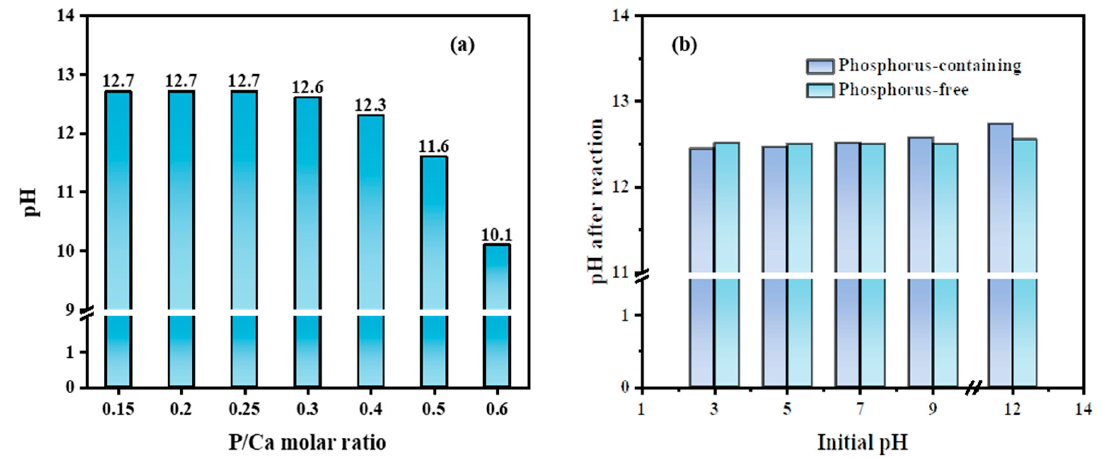
Figure 5. The pH of ( a ) P/Ca and ( b ) P i006E solution after reaction. To study the influence of the pH of the solution on the removal of B, acidic CaCl 2 instead of COS was used as a Ca 2+ source to precipitate P and remove B from solution. Re- moval efficiency increased as pH increased from 10 to 12.5, and peaked at pH 12.5, followed by a rapid decrease as pH increased (Figure 6). Dissolved B will occur in two different forms: the molecule [B(OH) 3 ] and its conjugated base, the borate ion [B(OH) 4 − ] [36,37]. Their predominance in the aqueous solution usually varied with pH. As the pH of the solu- tion increased, the concentration of [B(OH) 4 − ] increased and [B(OH) 3 ] decreased. B(OH) 4 − begins to appear at a pH of 6 and when the pH is 12.5, all boron is present as [B(OH) 4 − ] in solution. Therefore, the initial equilibrium of Eq. (4) cannot be maintained and the reaction between Ca 2+ and B(OH) 4 − happened to a greater extent to form more [CaB(OH) 4 ] + , which is easily attracted and adsorbed by HAP into solution. In addition, the pH will affect the surface charge of the material. Therefore, B was only removed under alkaline conditions. Contrary to this, it can be seen that B removal is related to the pH after the reaction rather than the initial pH of the